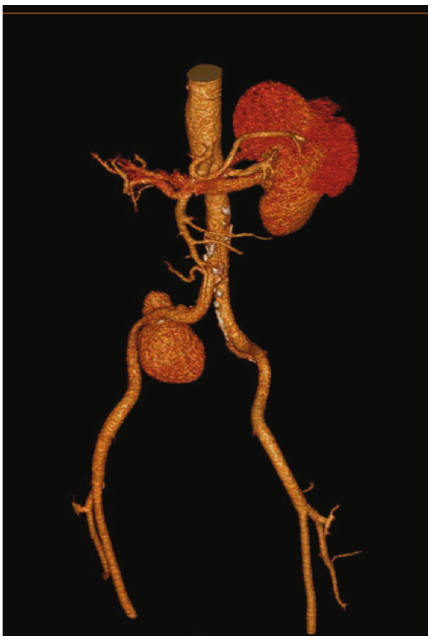
Figure 2: Multiplanar reformatted images show right internal iliac artery aneurysm just past the iliac bifurcation.